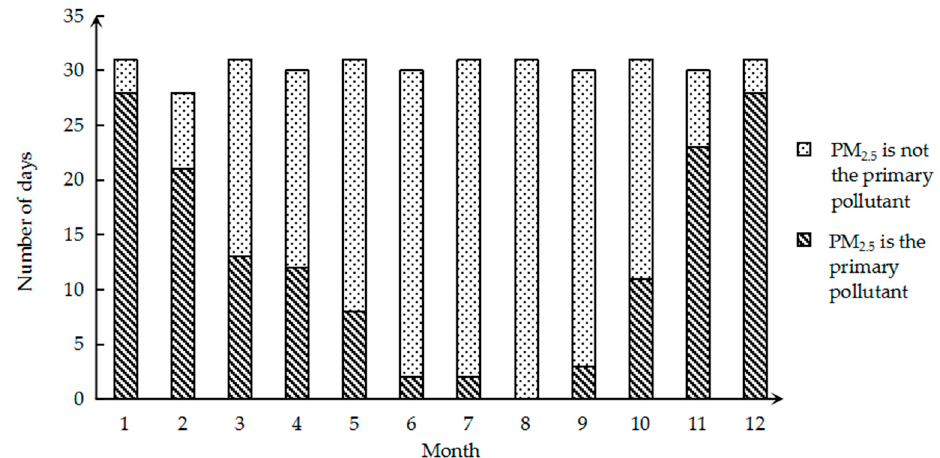
Figure 3. The number of days PM 2.5 was the primary pollution factor per month in 2017.